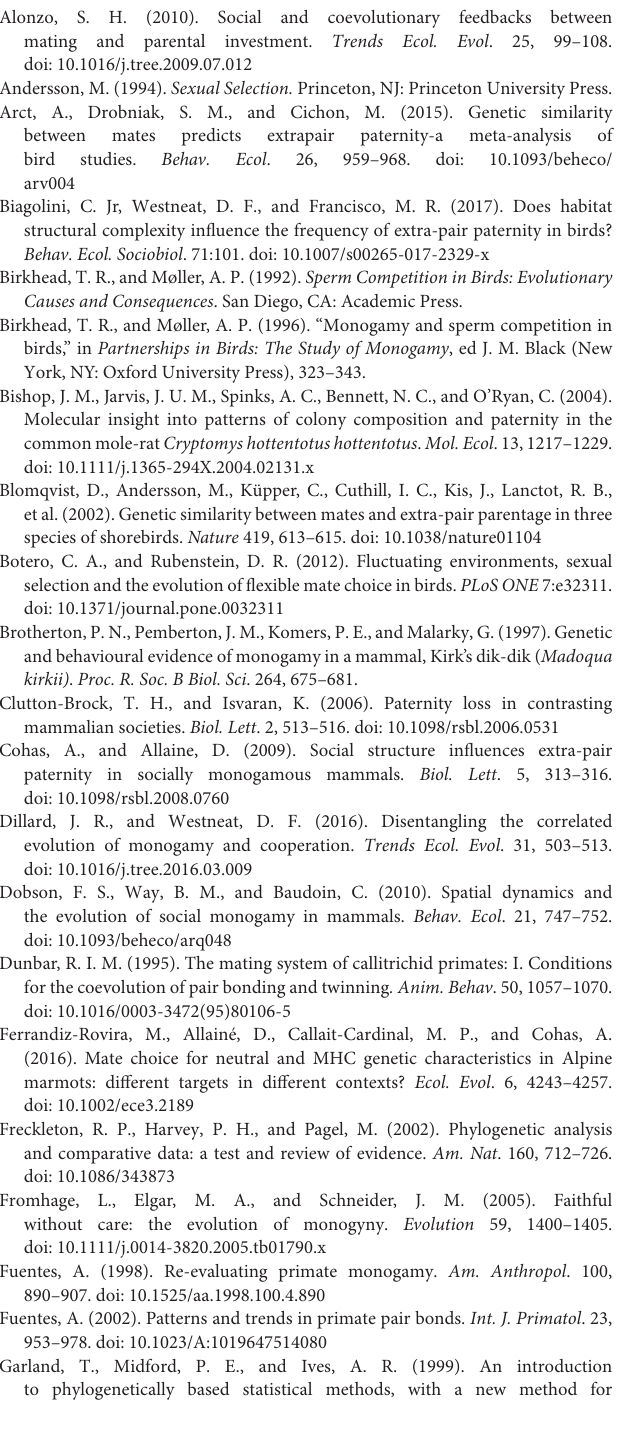
Supplementary Image 1 | The phylogeny of the 41 Mammalian species used for the phylogenetic regressions. Phylogeny was created by sub-setting the Mammalian supertree accessed from TimeTree (http://www.timetree.org/) on Dec 14, 2017 to the species used in each